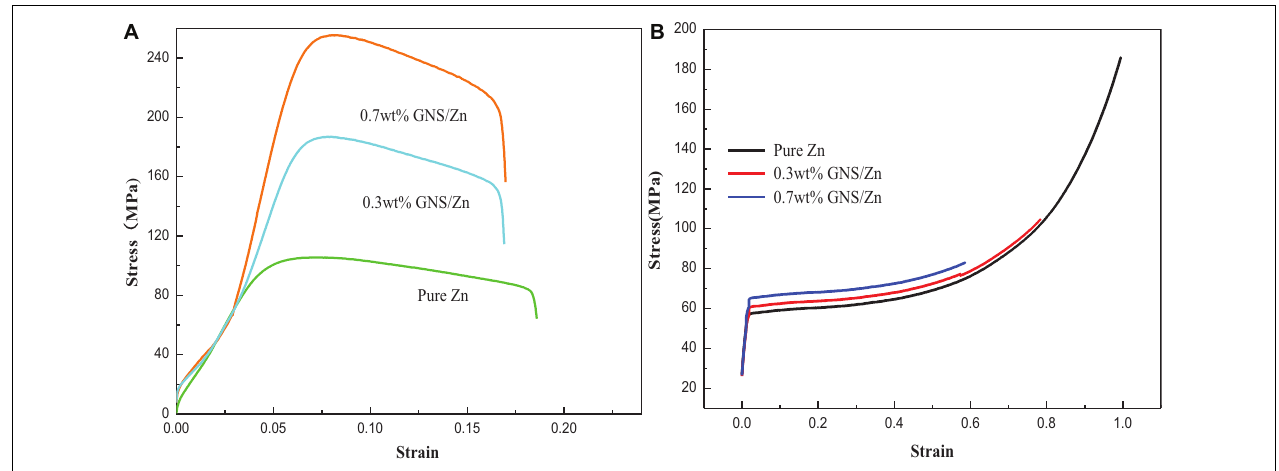
FIGURE 6 | TEM micrographs of GNS/Zn composite material show (A) the morphological characteristics of GNS, (B) the typical GNS layer existing in the Zn matrix (the illustration shows the dislocation morphology view after FTT conversion), (C,D) is the red selected area diffraction pattern in (A) , (E) FFT pattern obtained from the area shown in (B) , showing inter-planar distances of graphene (3.4 Å) and Zn (2.6 Å).